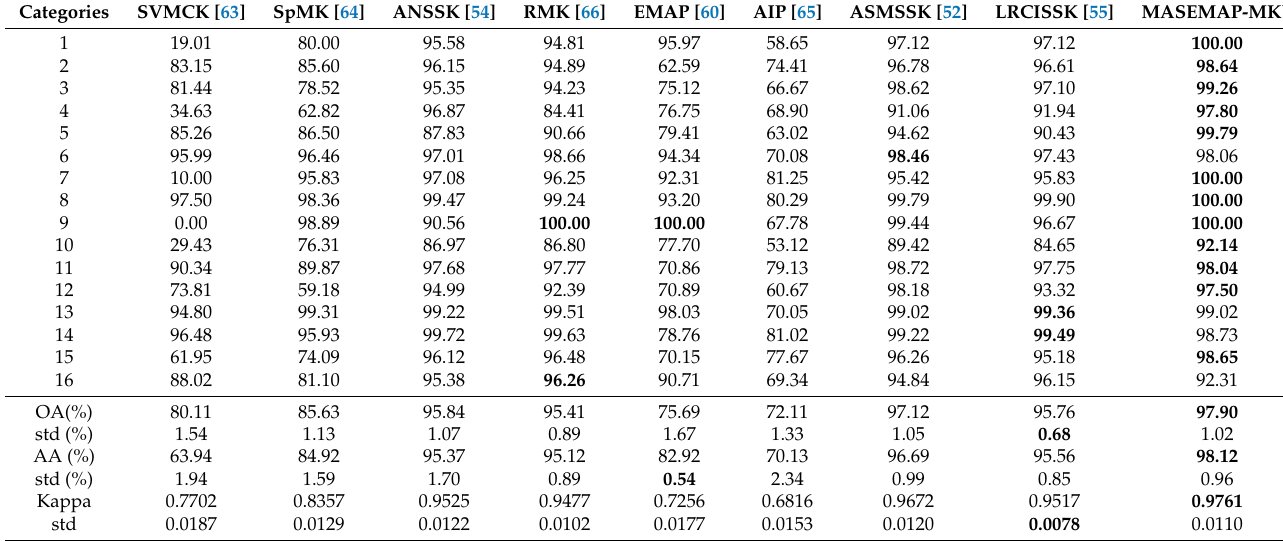
Table 2. Average classification accuracy (%) of all methods on the Indian Pines dataset with 2.7% labeled samples per class (the optimal results are highlighted in bold).